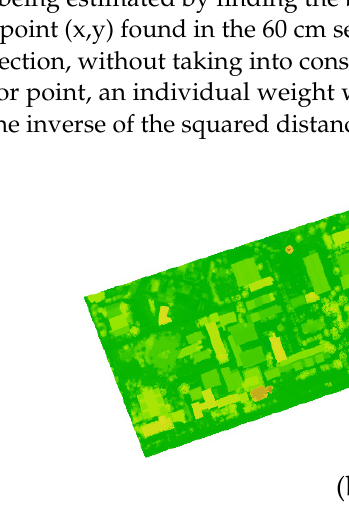
Figure 8. DSM of the study area in raster format, ( a ) using the robust moving planes interpolation method (0.2 m cell size, 0.6 m search radius, 20 neighbors), ( b ) obtained through a combination of interpolation methods, represented with the standard palette color coding.